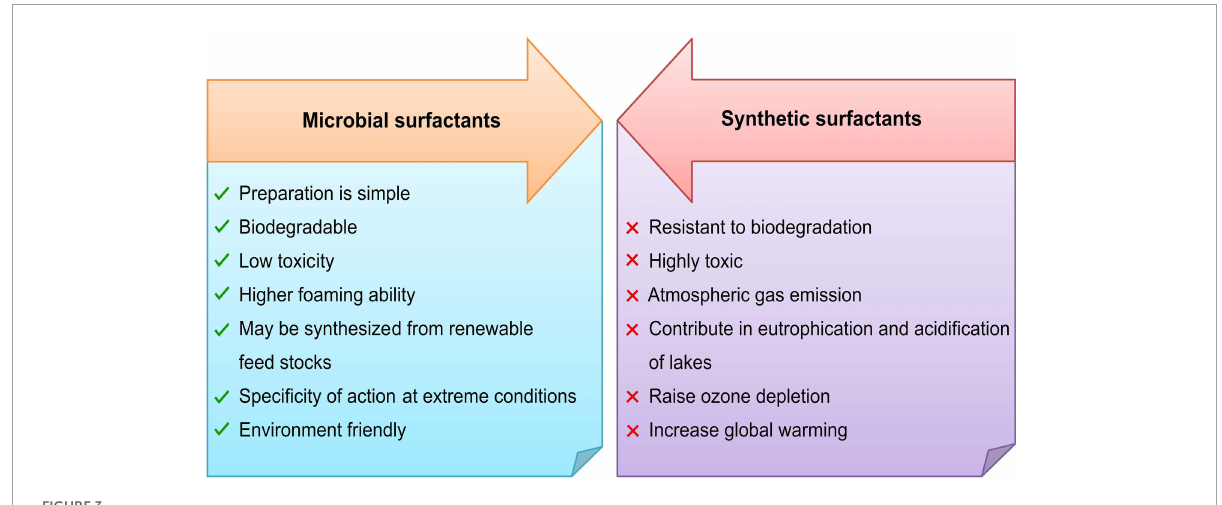
FIGURE3 Microbial surfactants verses synthetic surfactants.